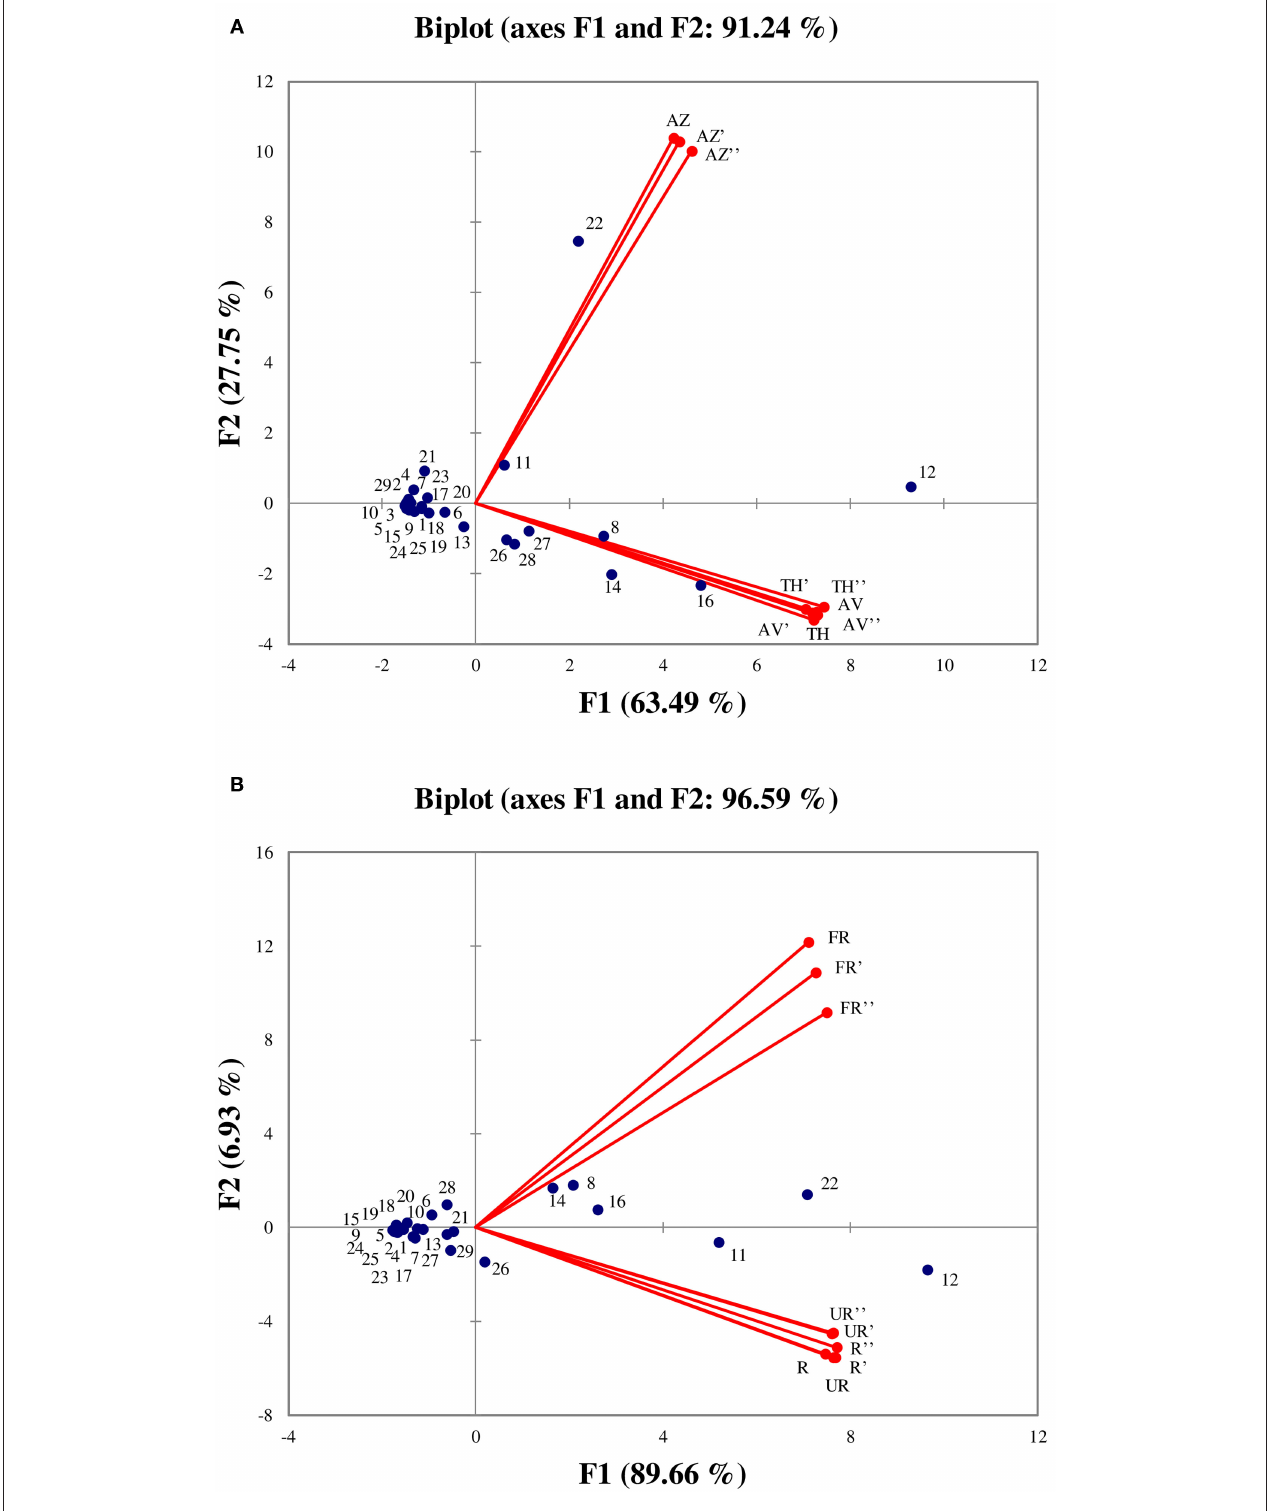
FIGURE 6 | Principal components analysis performed on all identified volatile organic compounds according to the three cultivars (A) , and between ripening stages (B) . (TH) Taamriwthe, (AV) Averkane, and (AZ) Azegzaw figs. The numbers correspond to the VOCs listed in Table 1 . U, unripe figs; R, ripe figs; FR, fully ripe figs.